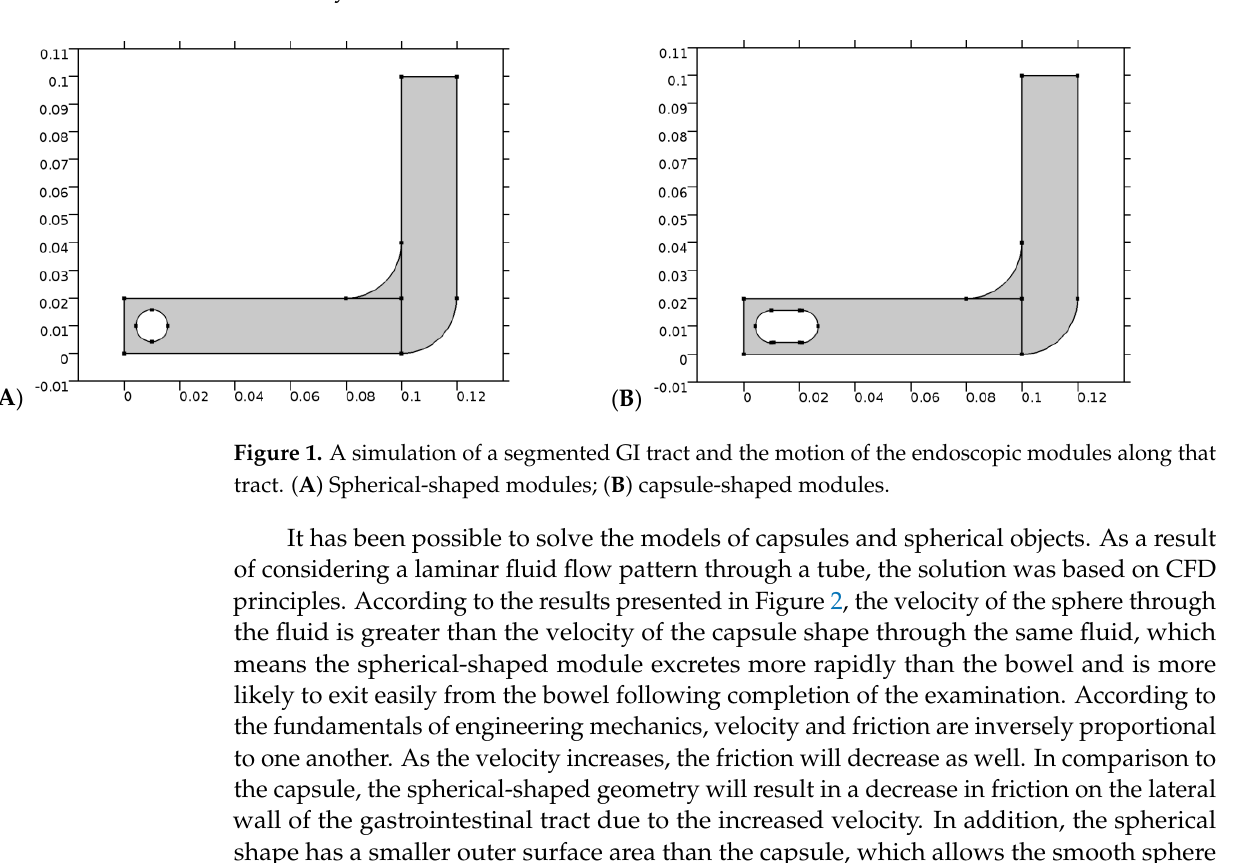
Figure 3. Comparison of pressure for spherical ( A ) and capsule ( B ) geometries in the GI tract. 2.2. Electronic Circuit Simulation As we know, electronic circuit simulators are electronic programs that allow us to capture schematics, simulate electronic circuits, and design electronic circuits. They are currently being used for a variety of purposes including studying the efficiency of equip- ment circuits, power consumption, distributed power in circuits, operational efficiency, and identifying devices with short shelf lives. There are a few programs that simulate electronic circuits, but the three most well- known ones are Multisim, Lab VIEW, and Proteus. An electronic circuit schematic can significantly improve the design efficiency of an electronic circuit by spotting faulty de- signs known in advance and inserting the correct ones into the behavior of an electronic circuit before it is built. Through the use of the Multisim program, the WCE project has followed the process of circuit design. As a result, it has a large library of electronic components such as